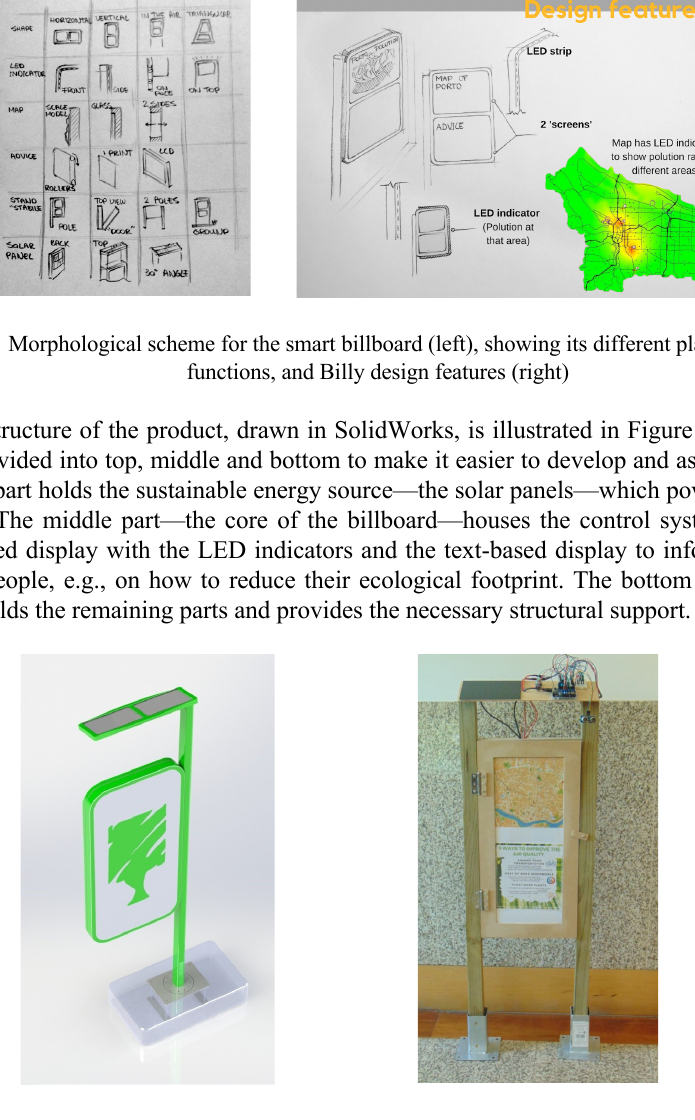
Fig. 3. 3D model of the designed structure (left) and completed prototype